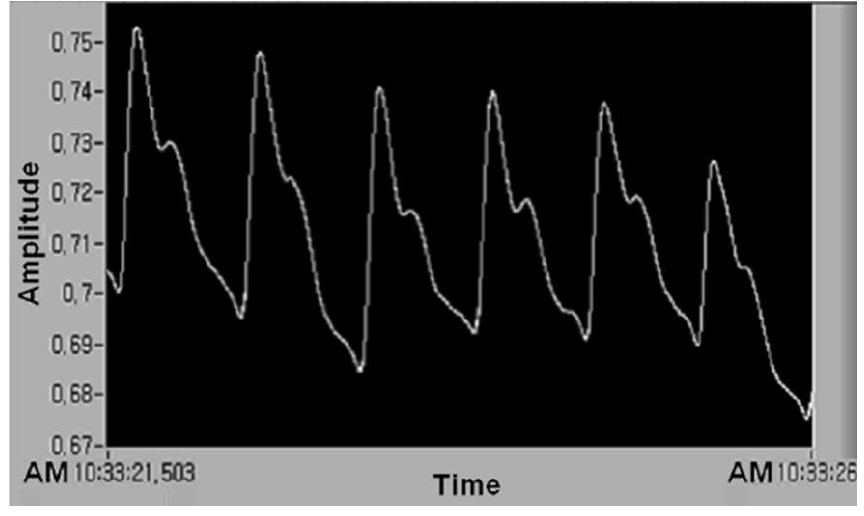
Figure 3. Typical pulse waveform of 1 point obtained by the compositional analysis of pulse signal of the clinical product testing of the pulsimeter using Hall device. Example of measuring time (seconds) versus temporally typical signal of 1 point pulse obtained from the analysis of an arbitrary pulse signal of 1 position of a small permanent